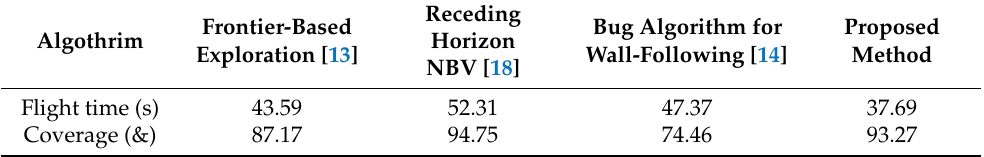
Figure 15. Exploration in maze environment visualization by ( a ) Bug algorithm for wall-following, ( b ) Frontier-Based Exploration, ( c ) Receding horizon NBV and ( d ) proposed frontier and sample- based exploration algorithm when voxel resolution of 0.1 m. Table 4. The flight time and coverage comparisons of Frontier-Based Exploration, Receding horizon NBV, Bug algorithm for wall-following exploration algorithm with proposed frontier and sample- based exploration in maze